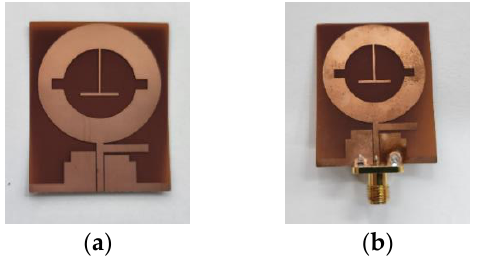
Figure 7. Photo of the antenna; ( a ) antenna without SMA connecter; ( b ) antenna with SMA con- necter.